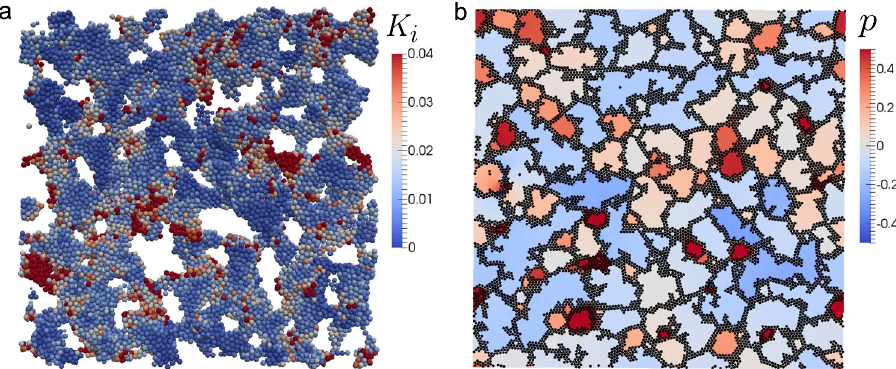
Fig. 7 Phase-separation patterns in 3D pure fl uid and in 2D colloidal liquid. a Real-space mapping of the kinetic energy of each particle K i in a single- component 3D LJ fl uid. Here we show a snapshot at time t = 45. The thermodynamic variables are chosen as ρ = 0.33 and T = 0.01. Particle colour represents the kinetic energy of the particle. b Phase separation in 2D colloidal suspension. A snapshot of a phase-separating 2D colloidal suspension ( ϕ = 38%) at zero temperature at t = 500. Here we show the pressure fi eld p in the solvent together with the position of colloids. The colour bar represents the